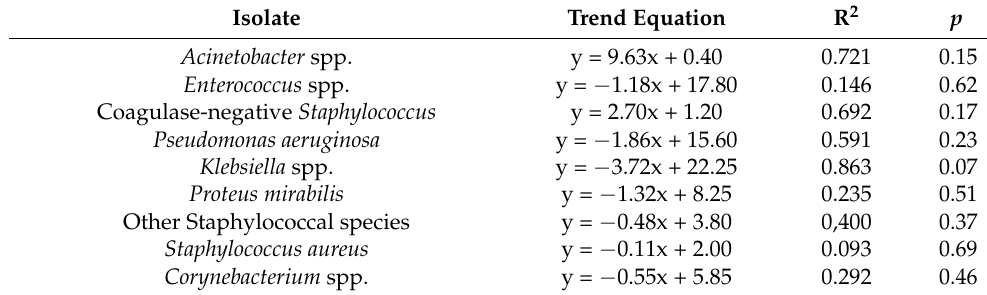
coagulase-negative Staphylococcus .